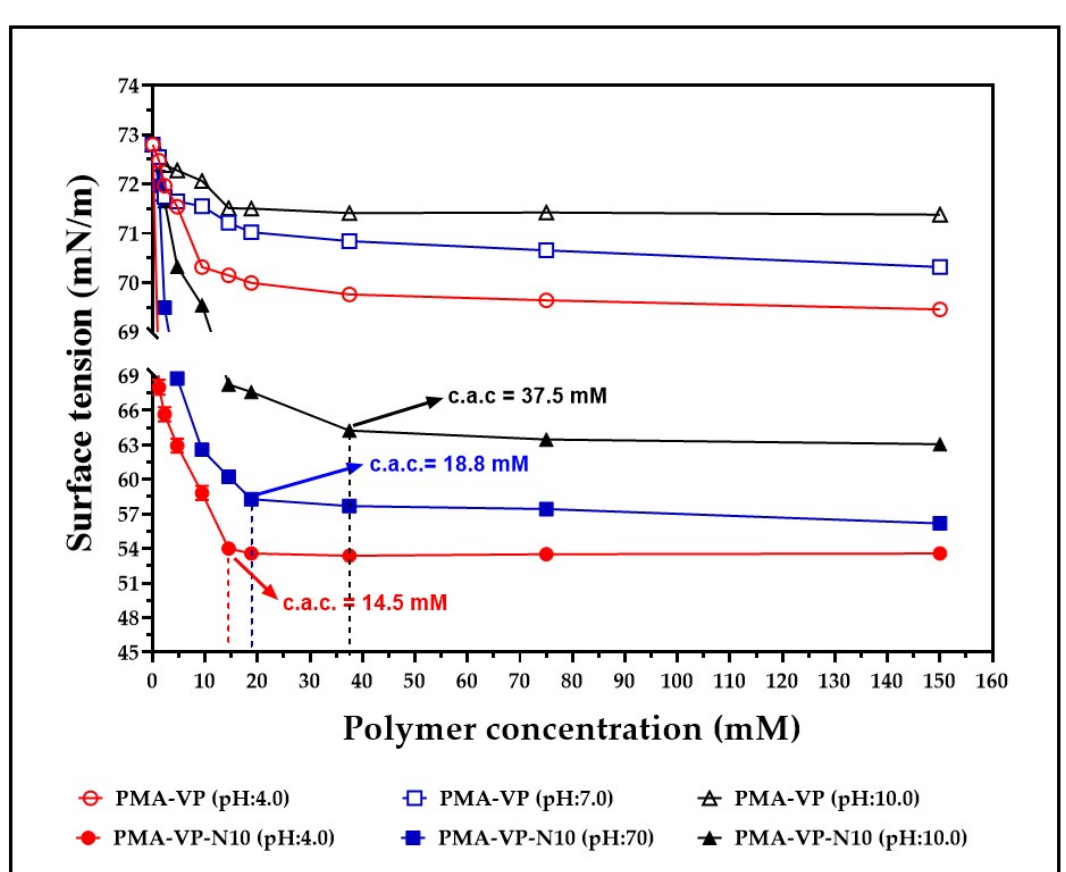
Figure 3. Surface tension characterization of aqueous solutions of PMA-VP and PMA-VP-N10 polymers at different polymer concentrations and medium pH values. c.a.c.: critical aggregation concentration of PMA-VP-N10 polymers.